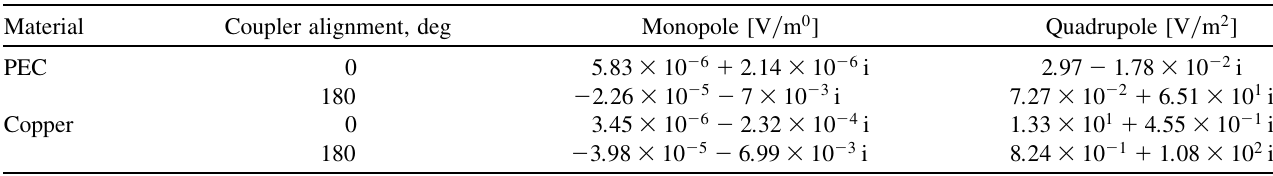
¼ 1 V for the CLIC crab cavity with dummy crab